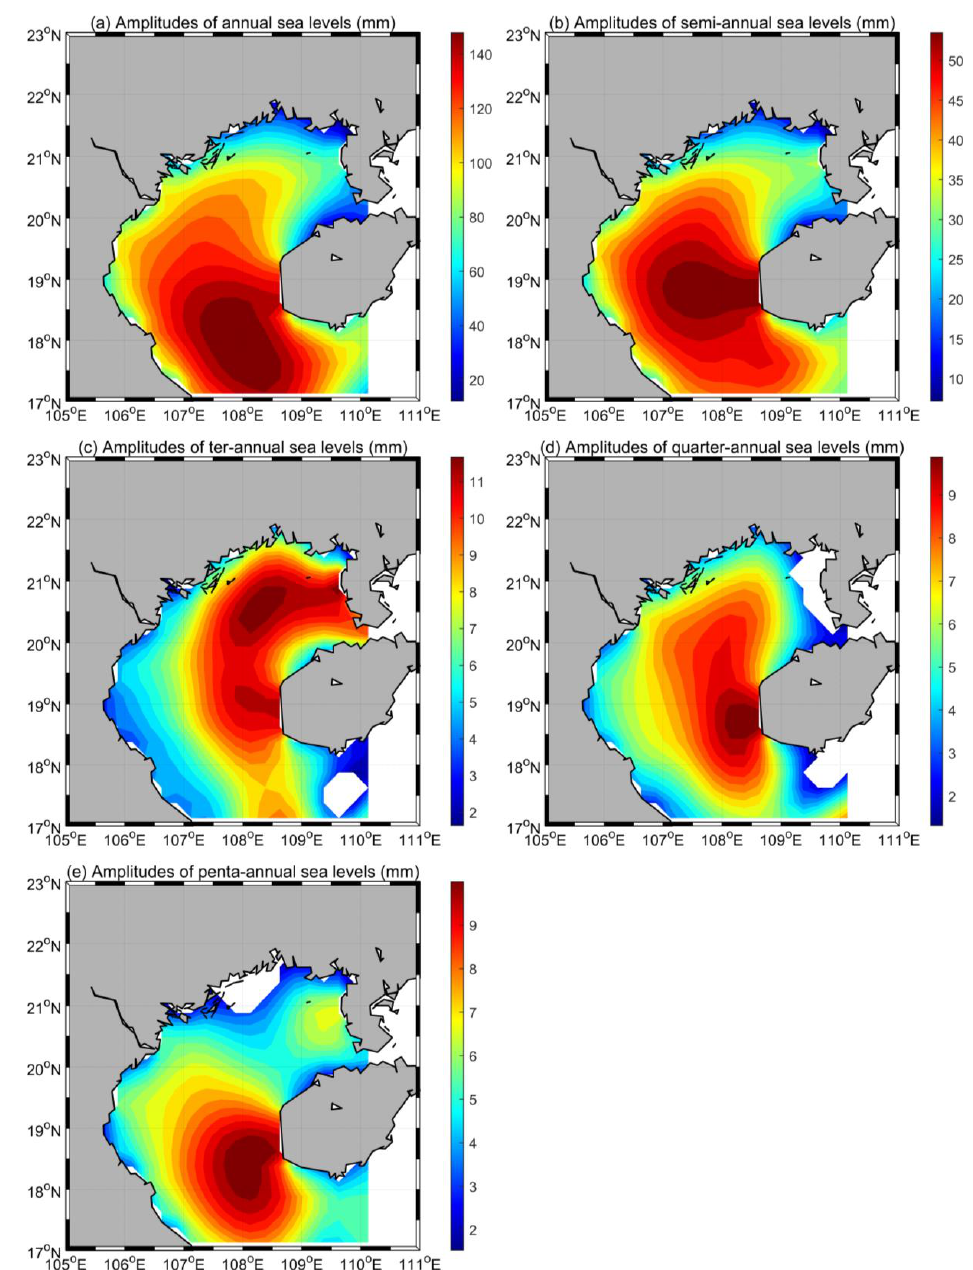
Figure 11. Estimated amplitudes (unit: mm) of the annual ( a ), semi-annual ( b ), ter-annual ( c ), quarter-annual ( d ), and penta-annual cycles ( e ) in gridded daily multi-satellite sea levels in the Gulf of Tonkin.